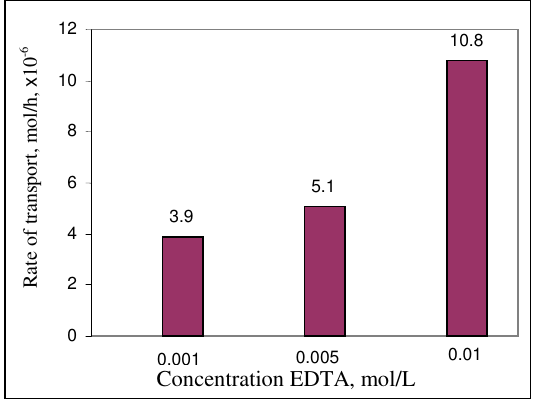
Figure 6. Effect of the EDTA addition in acceptor phase on the transport efficiency of Cu(II). Conditions: Initial concentration of [Cu(II), Mn(II), Zn(II) and Ni(II)] 10 mM, Benzoyl acetone 10 mM, Time: 5 h, pH: 4.5, Stirring rate: 8 rpm, Temperature: 25 0